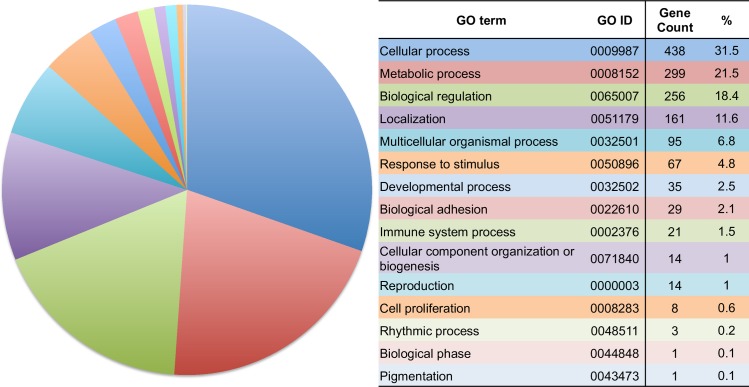
Simple aggregation of Gene Ontology (GO) terms among putative miR-379 target genes.The predicted miR-379 target gene dataset were fed into DAVID, version 6.8. Pie chart slices represent the number of genes associated with each GO term.